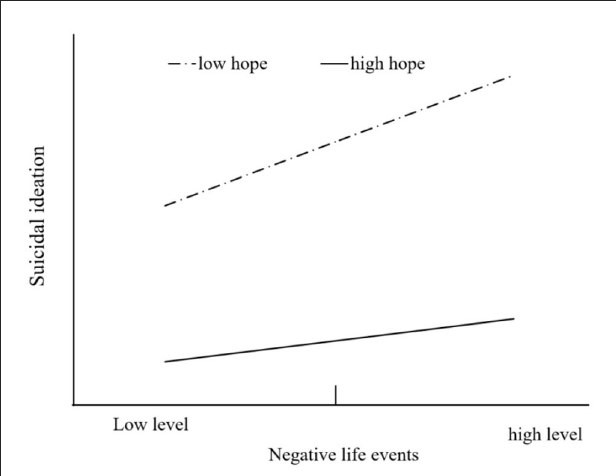
FIGURE2 Moderating effect of hope on the relationship between negative life events and suicidal